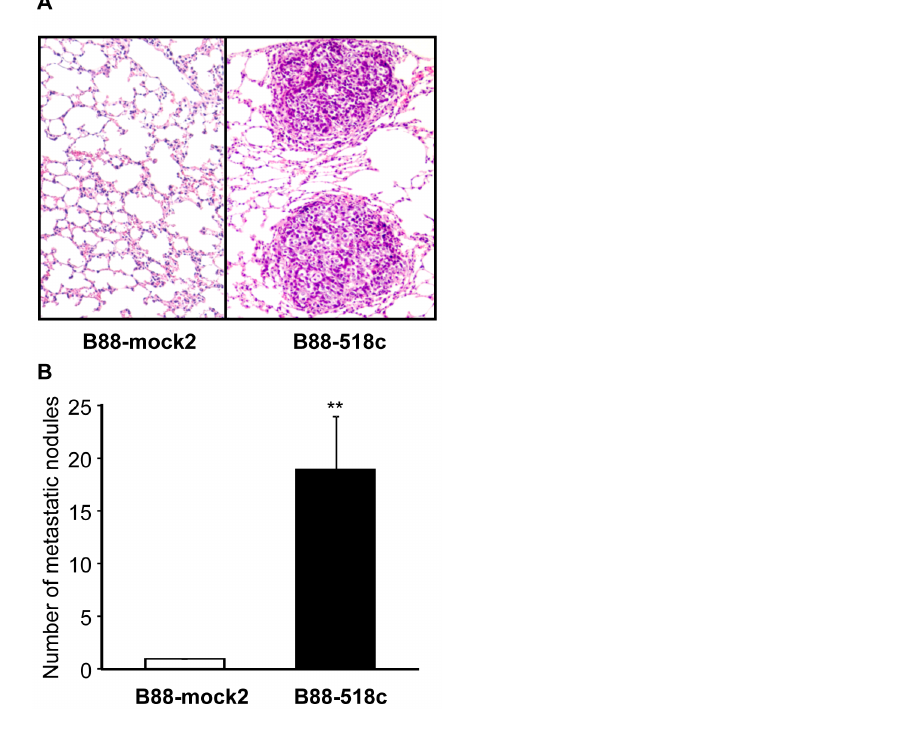
Fig. 6. The enhancement of lung metastases in miR-518c transfectants. Cells were inoculated into the blood vessels of nude mice, which were sacrificed at day 35. (A) Representative H&E staining of the lungs from the nude mice inoculated with B88-mock2 cells (left) and B88-518c cells (right). (B) The metastatic nodules were counted under a microscope. **, p , 0.01 when compared to mock cells by one-way